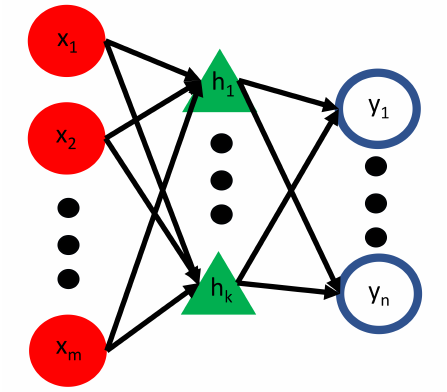
Figure 1. Schematic of neural network with single hidden